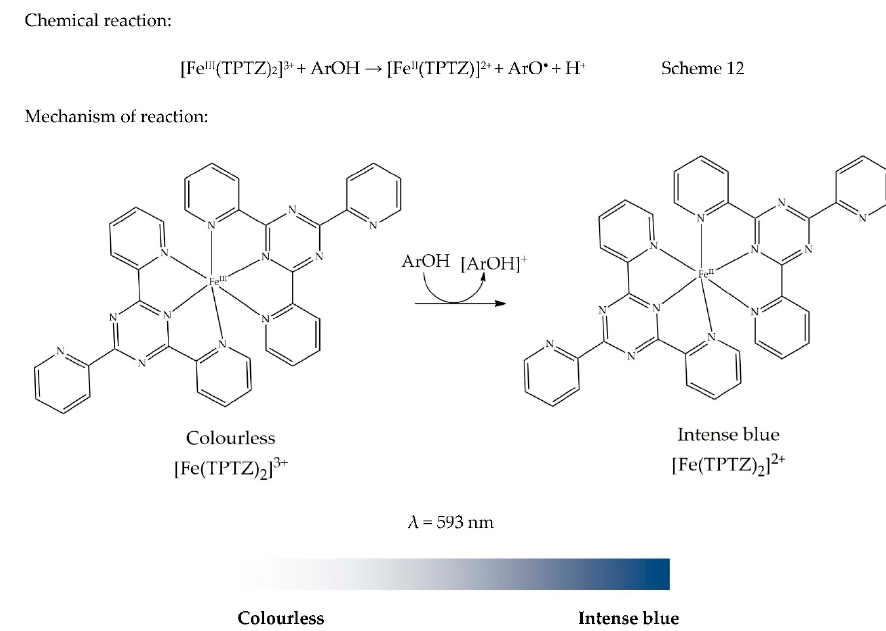
Figure 11. Ferric reducing antioxidant power ( FRAP) reaction mechanism.